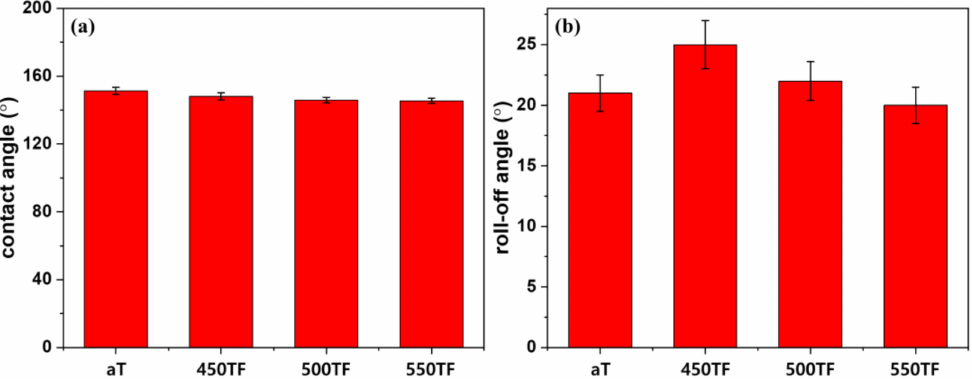
Figure 6. Superhydrophobic self-cleaning properties of the photocatalyst-treated PET fabrics; ( a ) contact angle and ( b ) roll-off